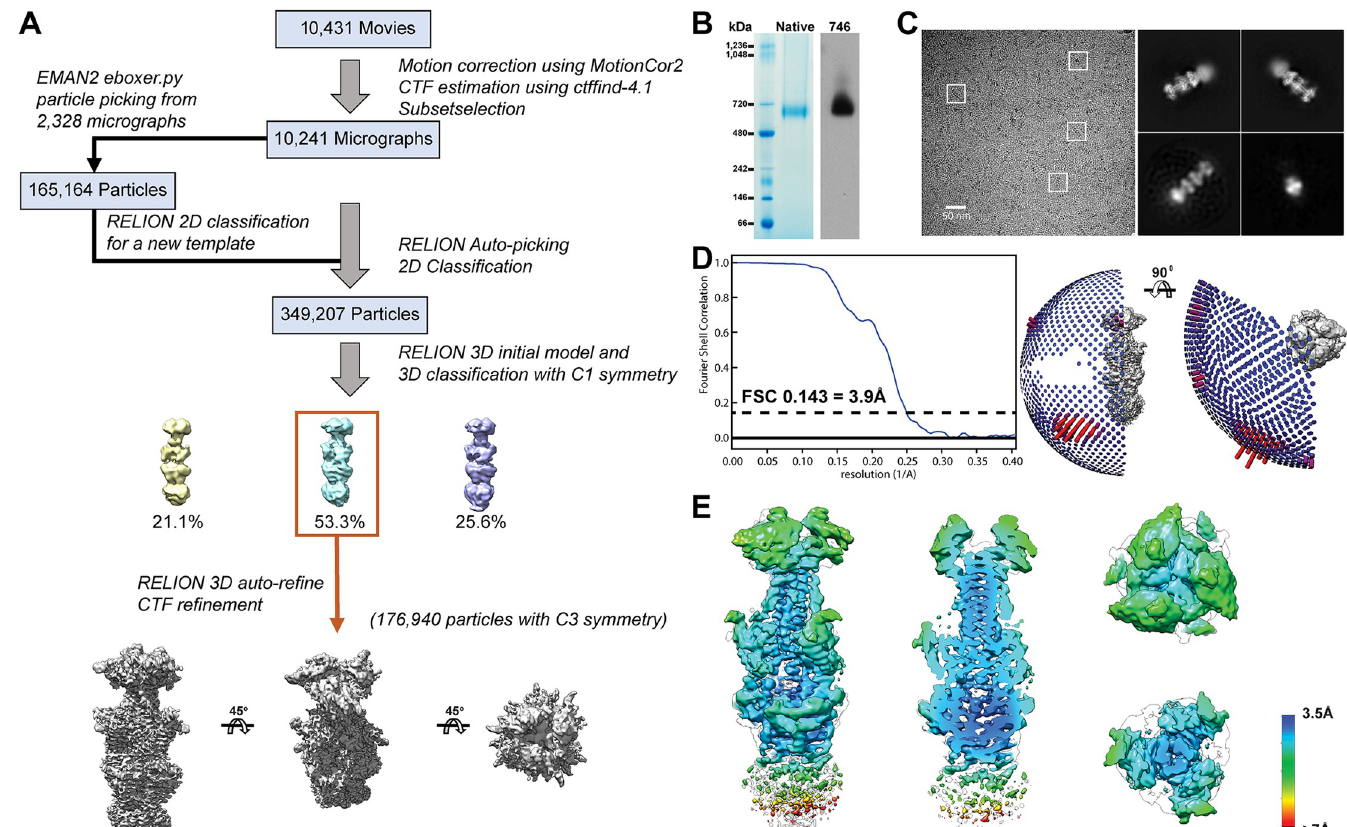
Fig 4. Single particle cryo-EM of native, full-length VZV gB. A–Classification scheme of VZV gB particles identified in Cryo-EM micrographs purified VZV gB frozen on lacey carbon grids. B–Native PAGE of purified VZV gB and western blots with VZV gB specific rabbit IgG 746–868. Molecular weights of the protein standards are given to the left of the gel (kDa). C–Single particle cryo-EM micrograph of a lacey carbon grid with purified VZV gB post size exclusion chromatography with four representative 2D class averages. D–Fourier shell correlation plot and Euler angle distribution of VZV gB particles included in the 3D reconstruction. E– Distribution of resolution ( Å ) of the VZV gB cryo-EM map calculated by